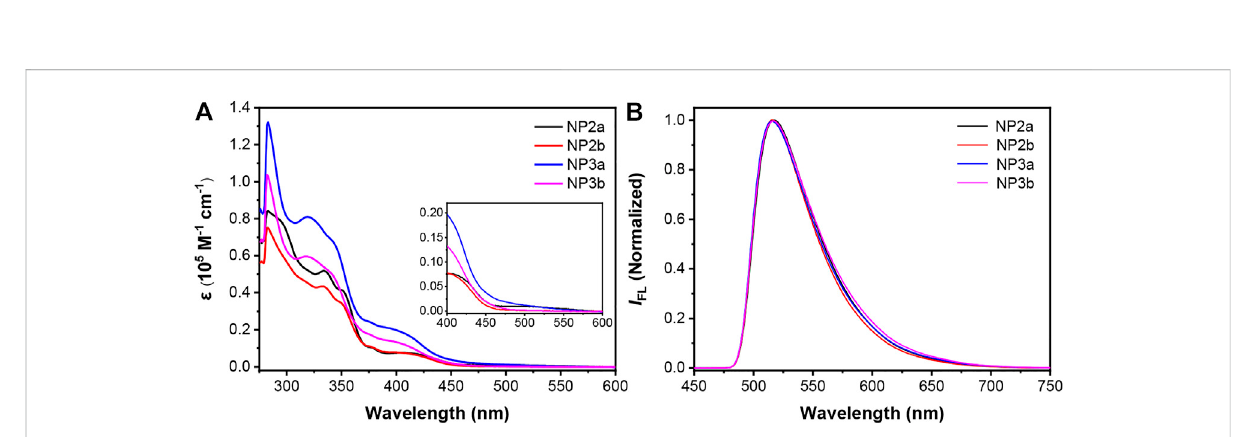
FIGURE 4 (A) UV − vis absorption and (B) normalized fl uorescence spectra of NP2a, NP2b, NP3a and NP3b measured in toluene (1 × 10 – 5 M). Inset in (A) shows the magni fi ed spectra at the long-wavelength region.